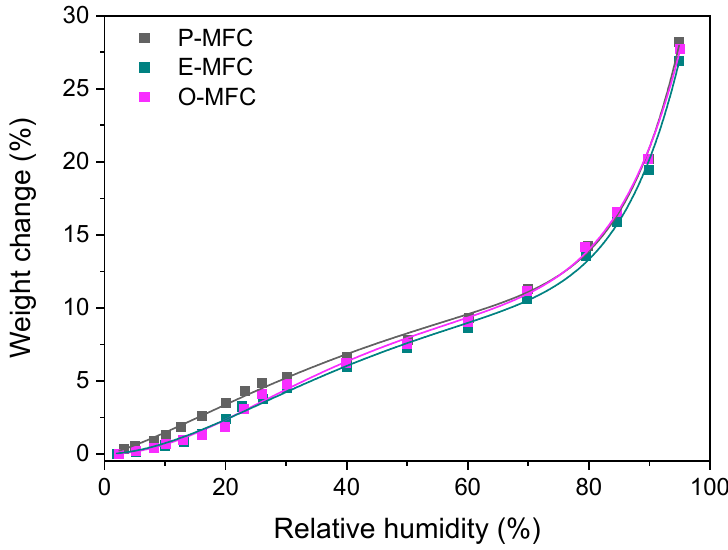
Figure 3. Water sorption isotherms of P-MFC, O-MFC and E-MFC films including the fitting curves according to Park’s model.